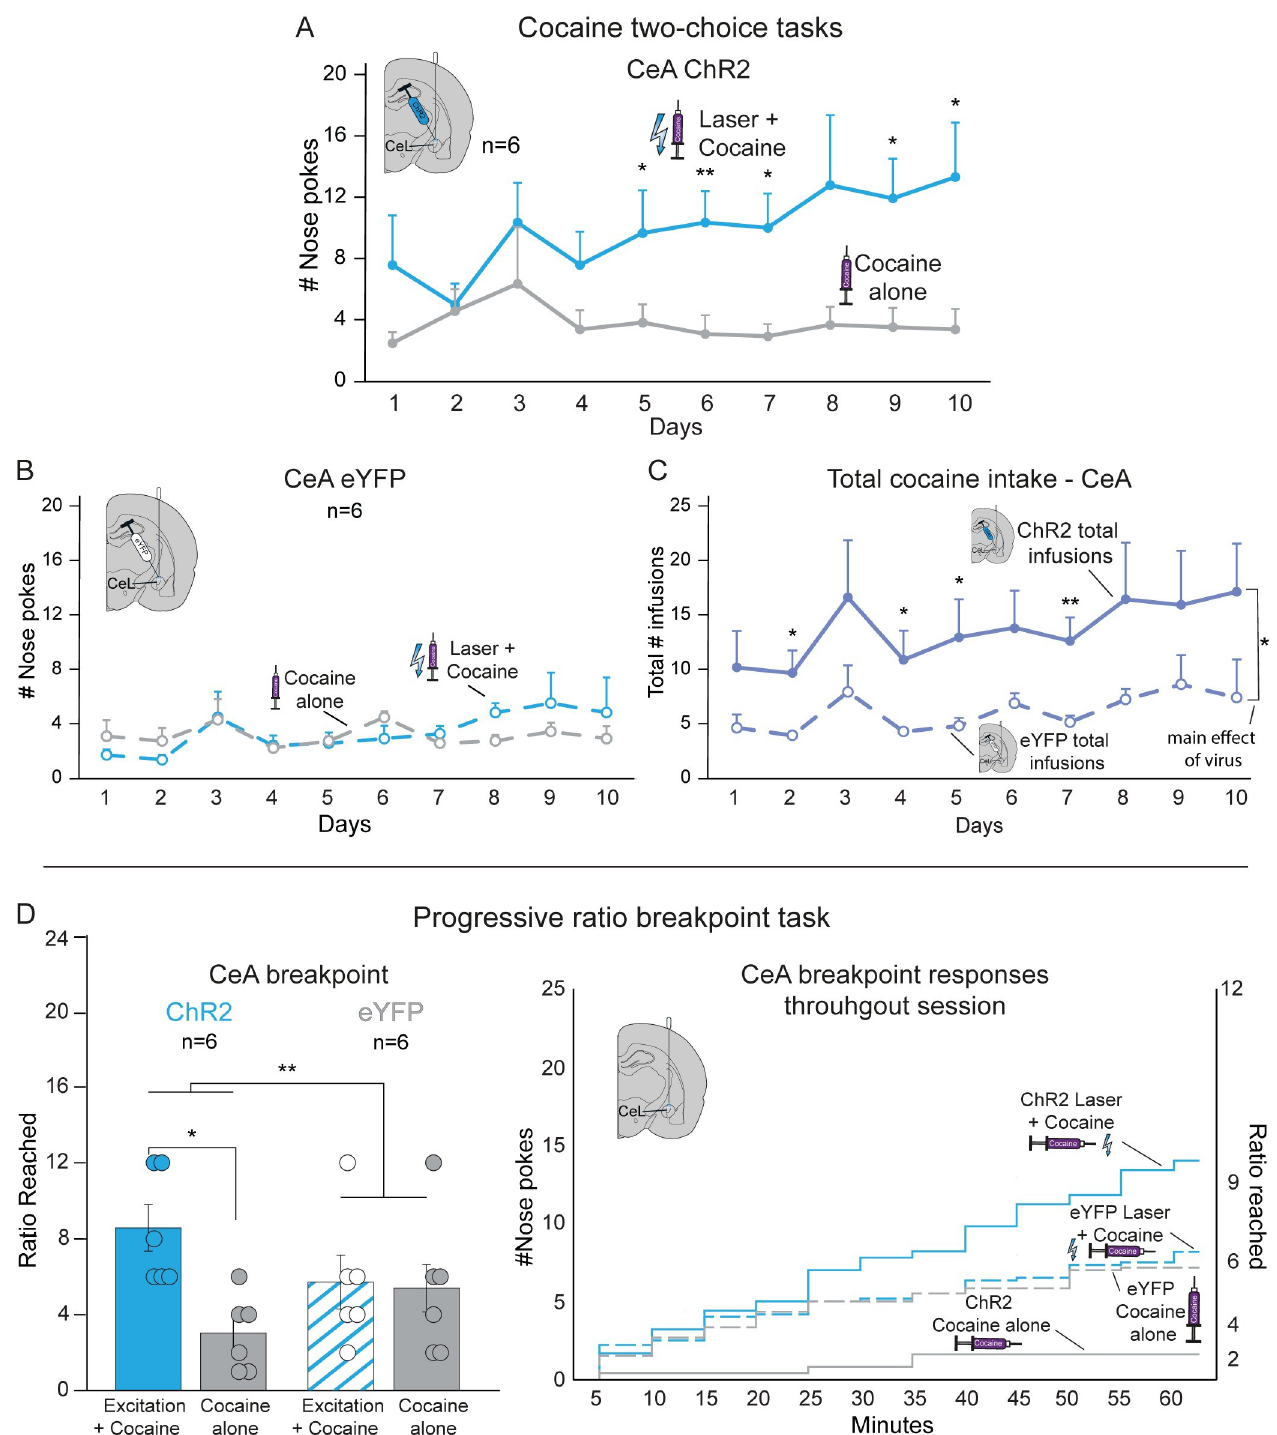
Fig 5. CeA ChR2 stimulation of CRF-containing neurons amplifies motivation and focuses preference on laser-paired cocaine. A) In the two-choice task, ChR2 excitation of CRF-containing neurons in the lateral CeA amplified cocaine pursuit and focused preference on the Laser+Cocaine option by a 4:1 ratio over Cocaine alone test (n = 6). B) In comparison, control CeA eYFP rats chose equally between options (n = 6). C) CeA ChR2 rats also had higher total cocaine intake in the two-choice task across all days than eYFP controls (combined intakes from both Laser+Cocaine plus Cocaine alone ). D) In a separate progressive ratio (PR) breakpoint test of incentive motivation intensity, CeA CRF neuronal excitation doubled effort breakpoint for cocaine in the Laser+Cocaine session over breakpoint of the same CeA ChR2 rats in their Cocaine alone session (n = 6; left panel). Laser did not affect breakpoint of CeA eYFP control rats (n = 6). Right panel depicts timeframe of behavioral responses for cocaine during the 1hr PR sessions. Means and SEM reported. � p < 0.05, �� p < 0.01.